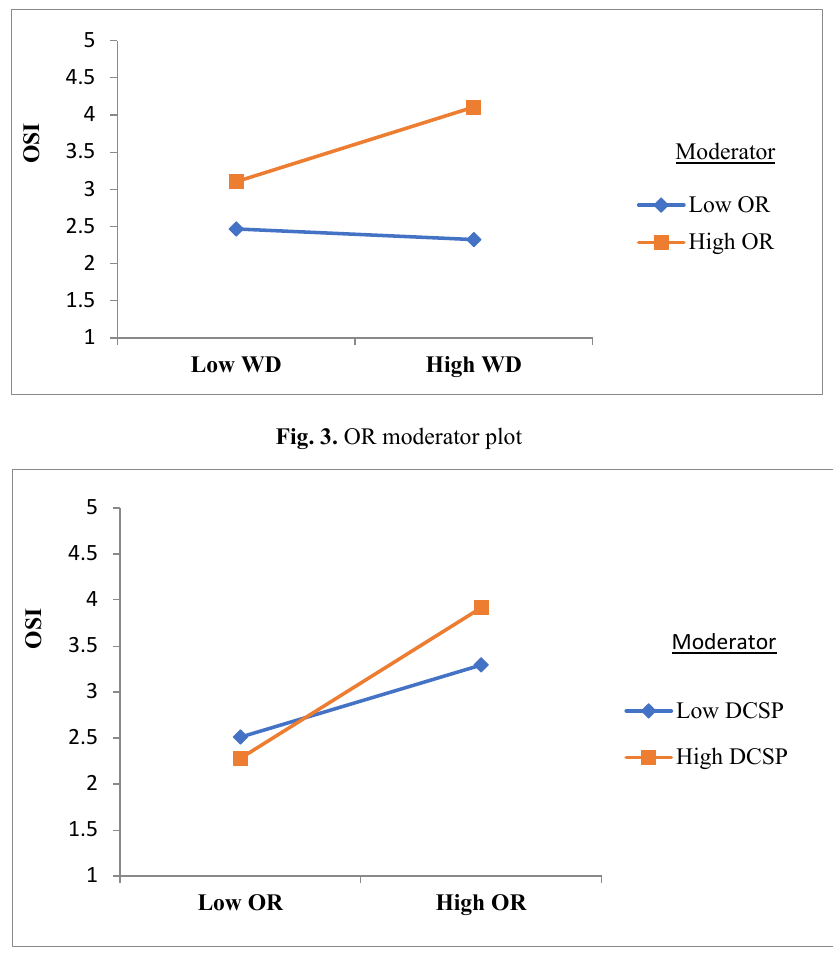
Fig. 4. DCSP moderator